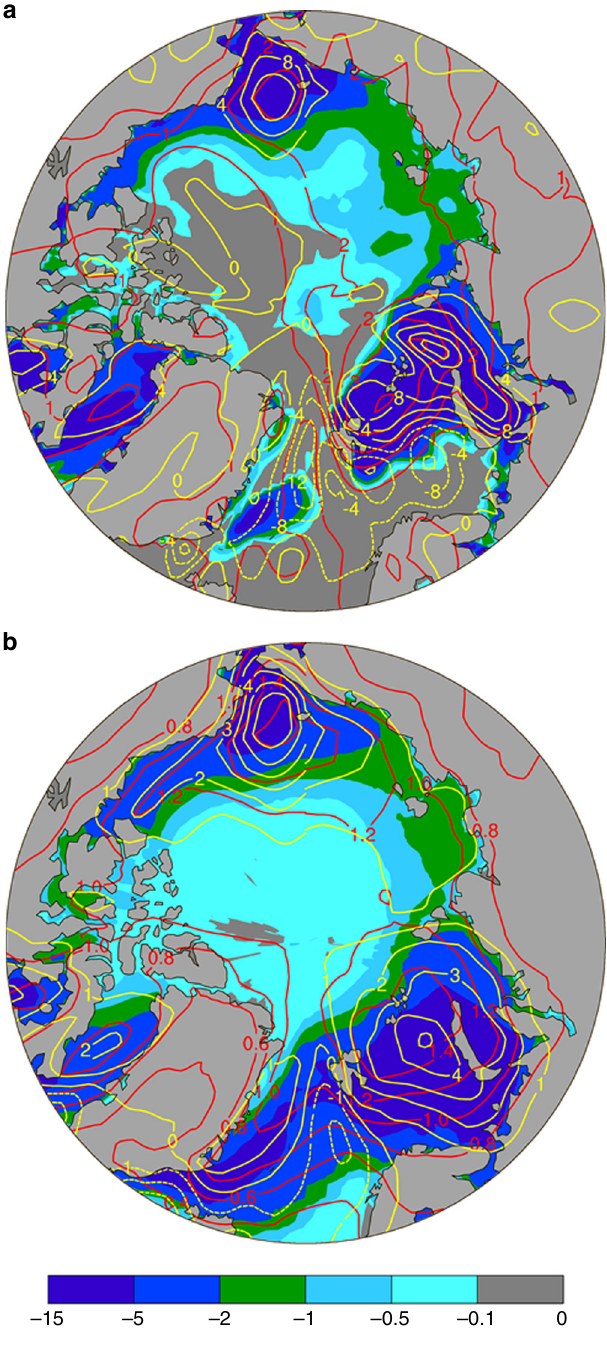
Fig. 2 Spatial distributions of the linear trends during 1979 – 2016. For November – December mean surface air temperature (red contours, K/ decade), sea-ice concentration (SIC, color shading, %/decade), and surface turbulent (sensible + latent) heat fl uxes (yellow contours, W/m 2 /decade, positive upward) based on a the ERA-Interim reanalysis data and b the ensemble mean of historical (for 1979 – 2005) and RCP8.5 (for 2006 – 2016) simulations averaged over 38 CMIP5 models. The SIC trends are similar to those based on NOAA satellite data from https://sidads.colorado.edu/ DATASETS/NOAA/G02202_V3. Spatial pattern correlations: Trend pattern correlations: r (SIC,Tas) = − 0.61, r (SIC,LH + SH) = − 0.68, r (Tas, LH + SH) = 0.56 in a ; and r (SIC,Tas) = − 0.40, r (SIC,LH + SH) = − 0.70, r (Tas,LH + SH) = 0.65 in b . The upward longwave radiation trend (not shown) is highly correlated with the air temperature trend (r ≥ 0.96). These correlations have a p -value well below